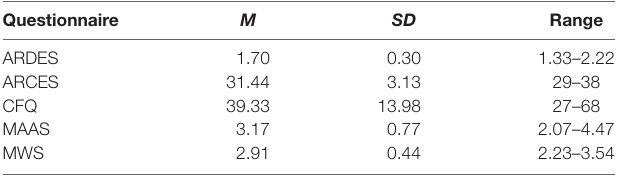
TABLE 1 | Descriptive Statistics ( M , SD ) for